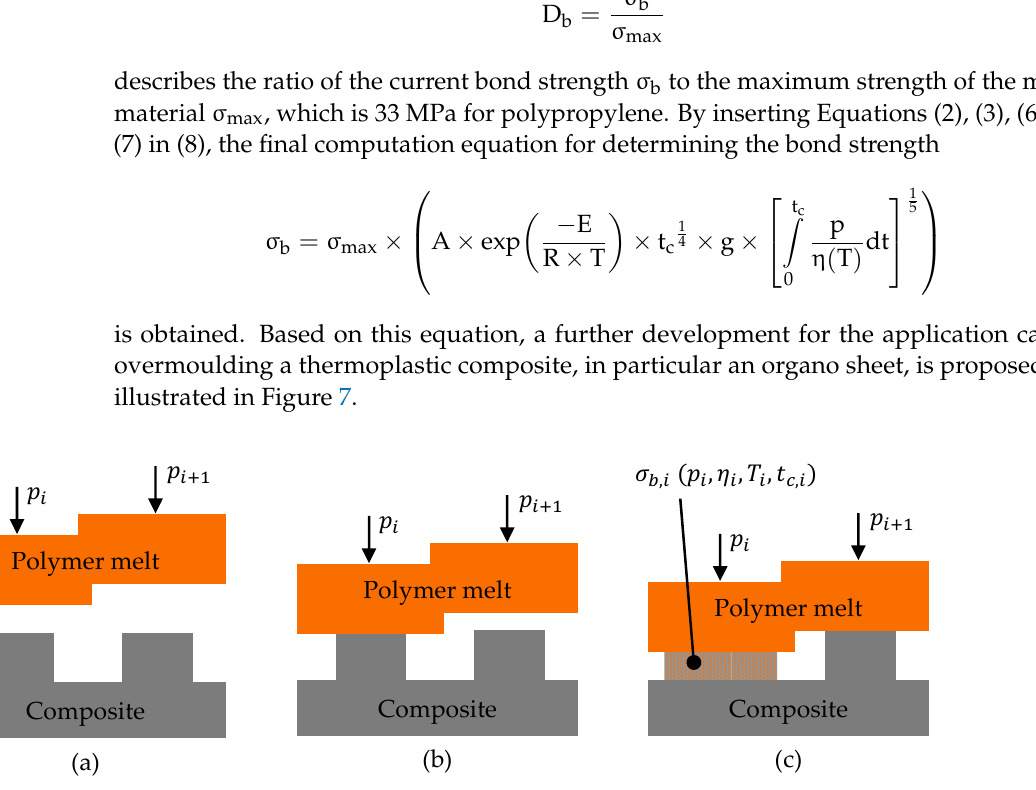
Figure 7. Modified approach for determining the local bond strength as a function of pressure, temperature and contact time with the process steps: no contact ( a ), local intimate contact ( b ) and local autohesion ( c ).